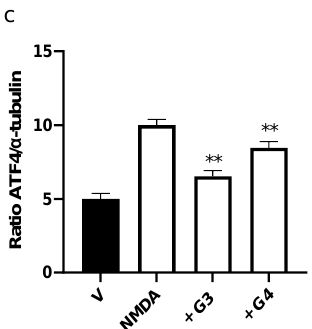
Figure 6. Quantification of the effect of phosphorous dendrimers on NMDA-induced changes in